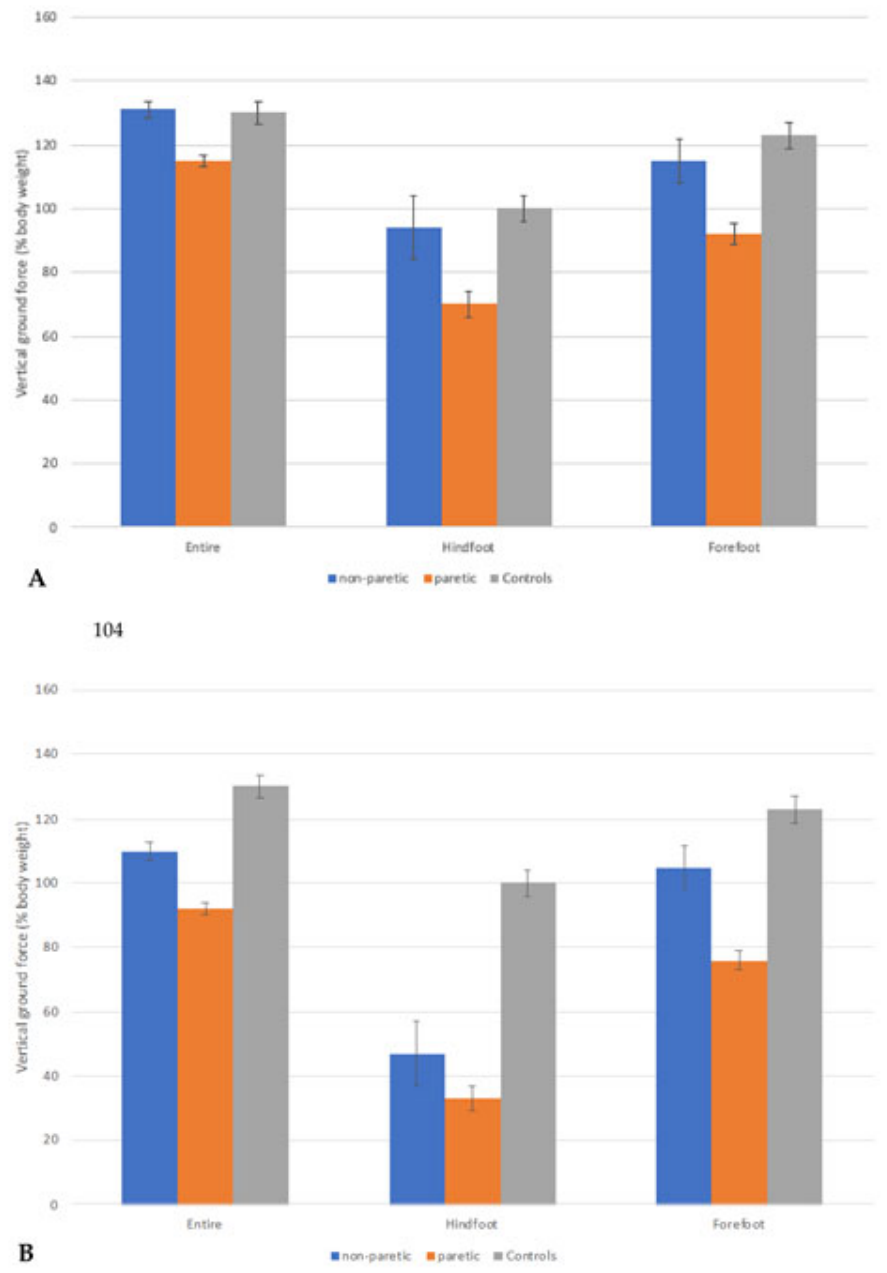
Figure 3. Means and standard deviations (error bars) of vertical GRF (% bodyweight) from eight gait cycles during comfortable walking for 59- and 73-year-old stroke patients ( A , B ), respectively. Outcomes are presented for the paretic and non-paretic legs—the vertical GRF of healthy gait is also included as a visual reference of “normality”. The GRF of healthy gait was derived from eight elderly volunteers recruited from the community who had no medical conditions that could have limited their walking ability.